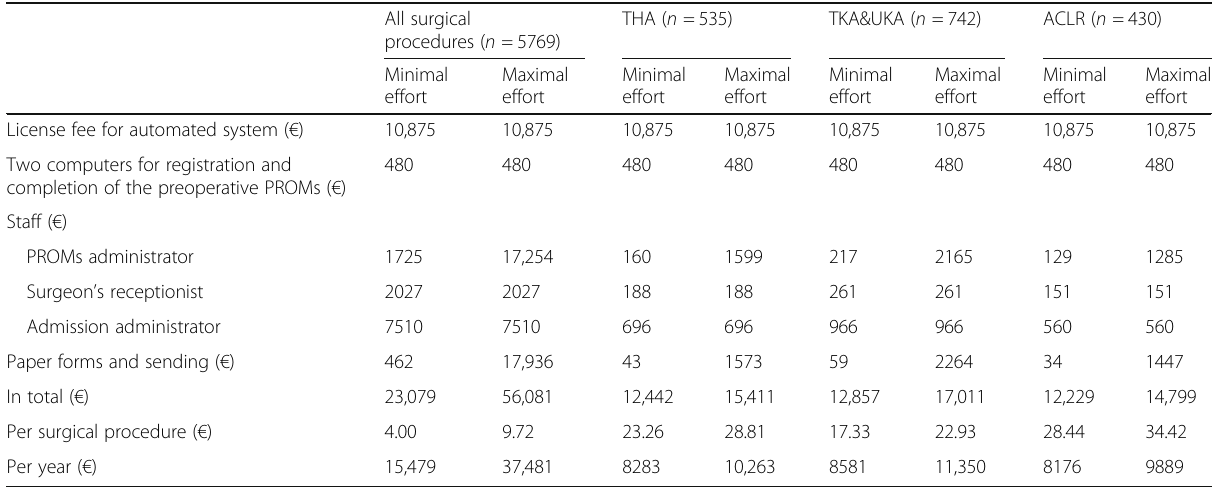
Table 2 Costs of PROs collection: minimal effort versus maximal effort